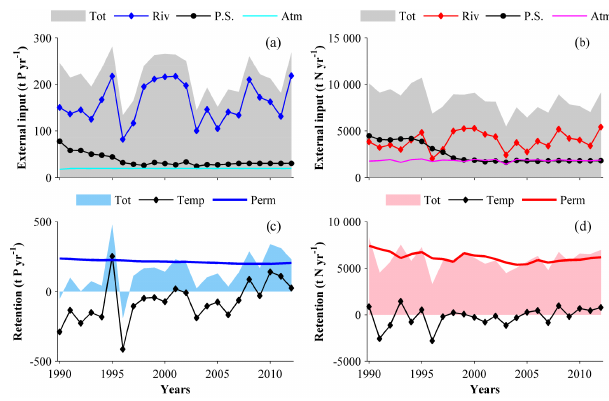
Figure 11. The retention per area unit (tkm − 2 yr − 1 ) of P (left) and N (right) in each basin of the Stockholm